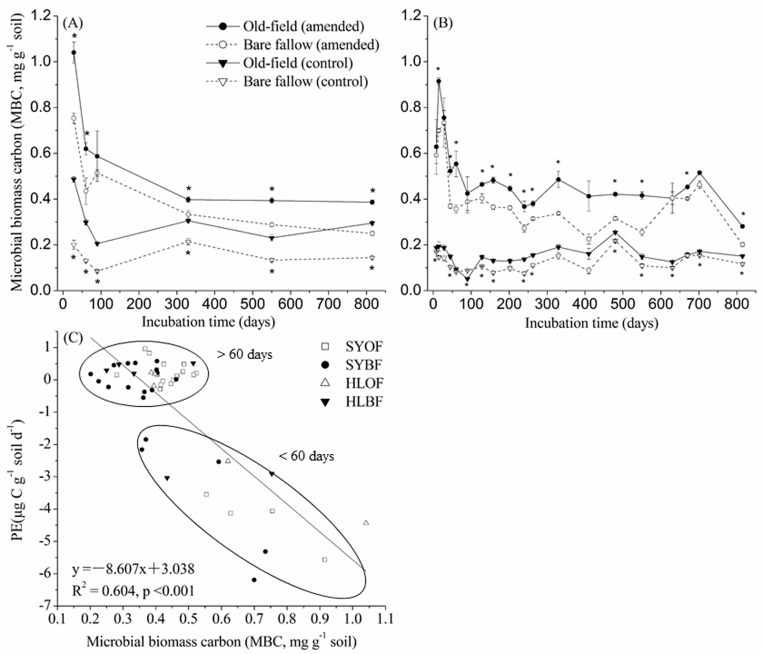
Soil microbial biomass carbon (mg g-1
soil) from Hailun (A) and Shenyang (B) station through incubation time and correlation between PE (priming effect) and MBC (microbial biomass carbon) (C). *indicates significant differences between old-field and bare fallow treatments. The PE data were the instantaneous priming effect. Both the PE and MBC data were mean values of 3 replicates at each sampling time (day-8, 14, 28, 45, 60, 90, 128, 158, 202, 240, 263, 330, 410, 480, 550, 630, 670, 702 and 815). Solid line is the regression line between PE and MBC. Error bars show ±1 SE.